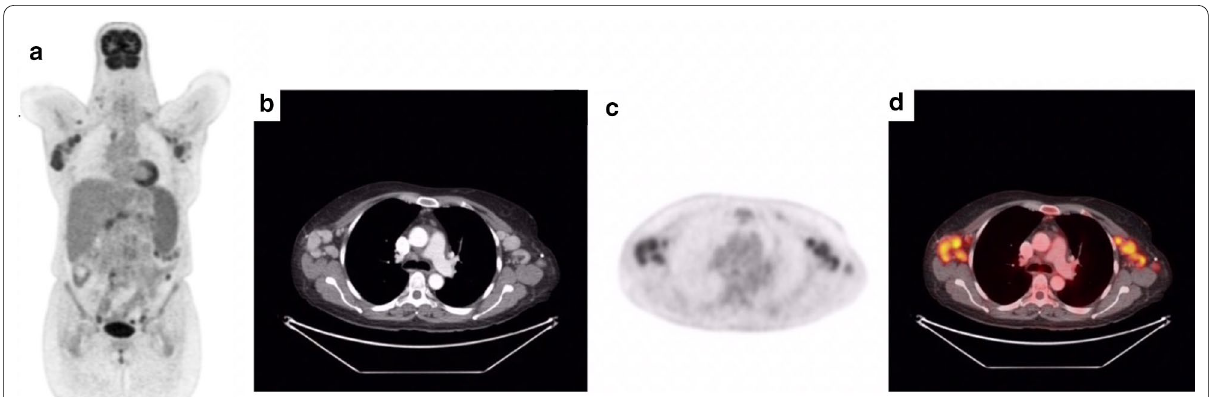
Fig. 2 a displays the PET scan of a subject with multicentric Castleman disease (MCD) in the coronal view. Enlarged axillary and cervical lymph nodes and an enlarged spleen are seen in a , demonstrating the systemic nature of MCD. b–d display the CT, PET, and PET/CT cross‑sectional scans of the subject’s thorax, respectively. d displays high uptake of lymph nodes in the right and left axillary regions as shown in